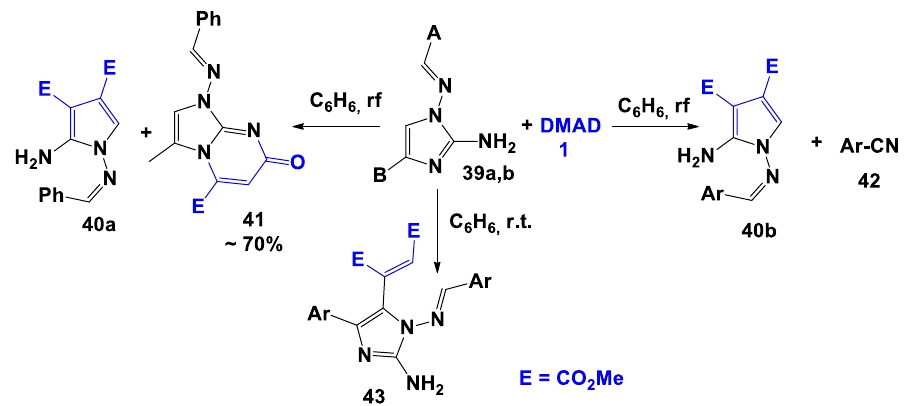
Table 1. Content of 1,2-diamino-4-phenylimidazole determined by the reaction mass (%). Solvent